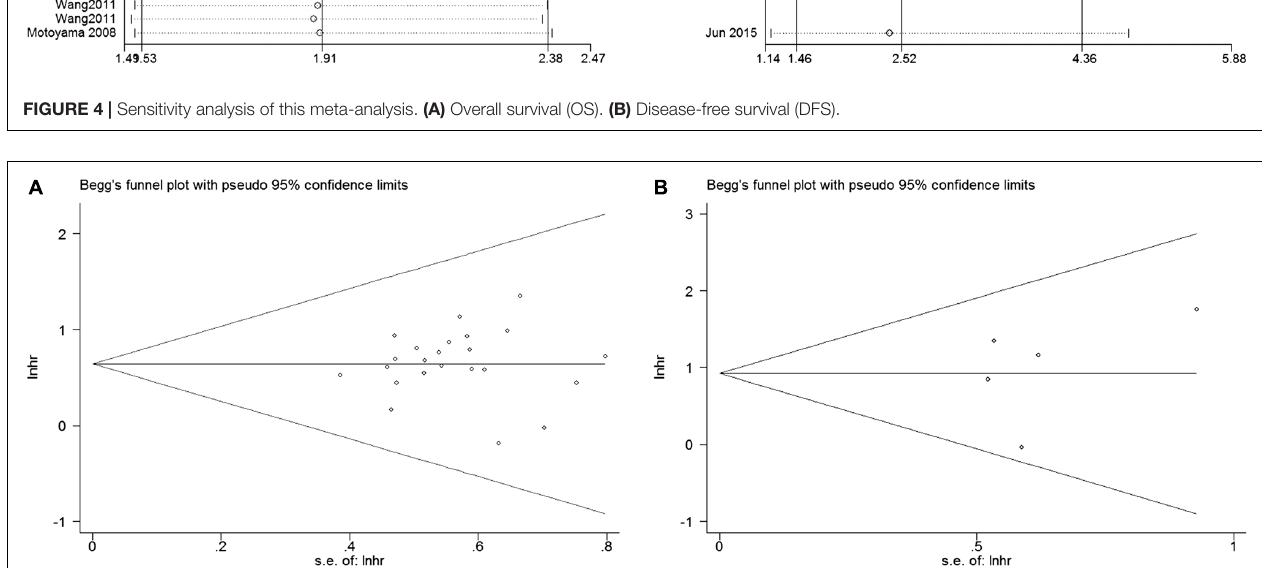
FIGURE 5 | Begg’s funnel plots for the studies involved in the meta-analysis of HMGA2 expression and the prognosis of patients with cancers. (A) Overall survival. (B) Disease-free survival. loghr, logarithm of hazard ratios; s.e., standard error.